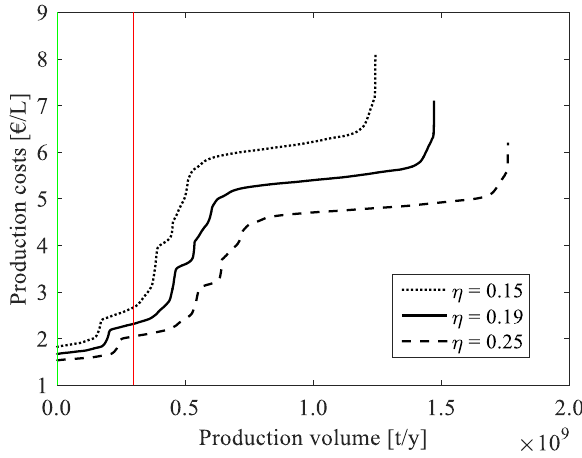
Figure A4. The cost-supply curve of solar thermochemical jet fuel for South America (Chile, Bolivia, Peru, Argentina) with current national jet fuel demand [94] ( green line ) and world jet fuel demand [92] ( red line ).